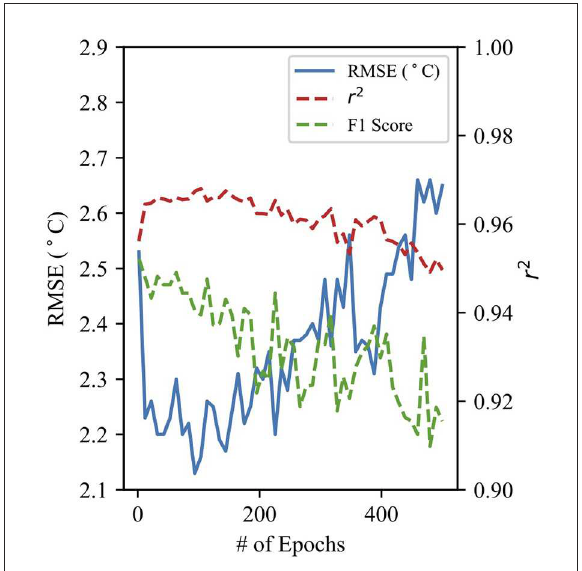
FIGURE1 Performance statistics for the CNN 24-h prediction model as a function of the number of epochs used by the